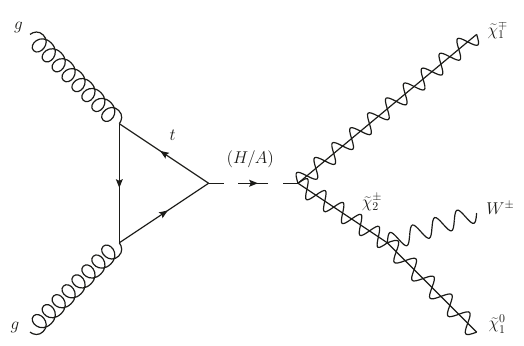
Figure 21. The Feynman diagram for the production of W ± χ 0 e 1